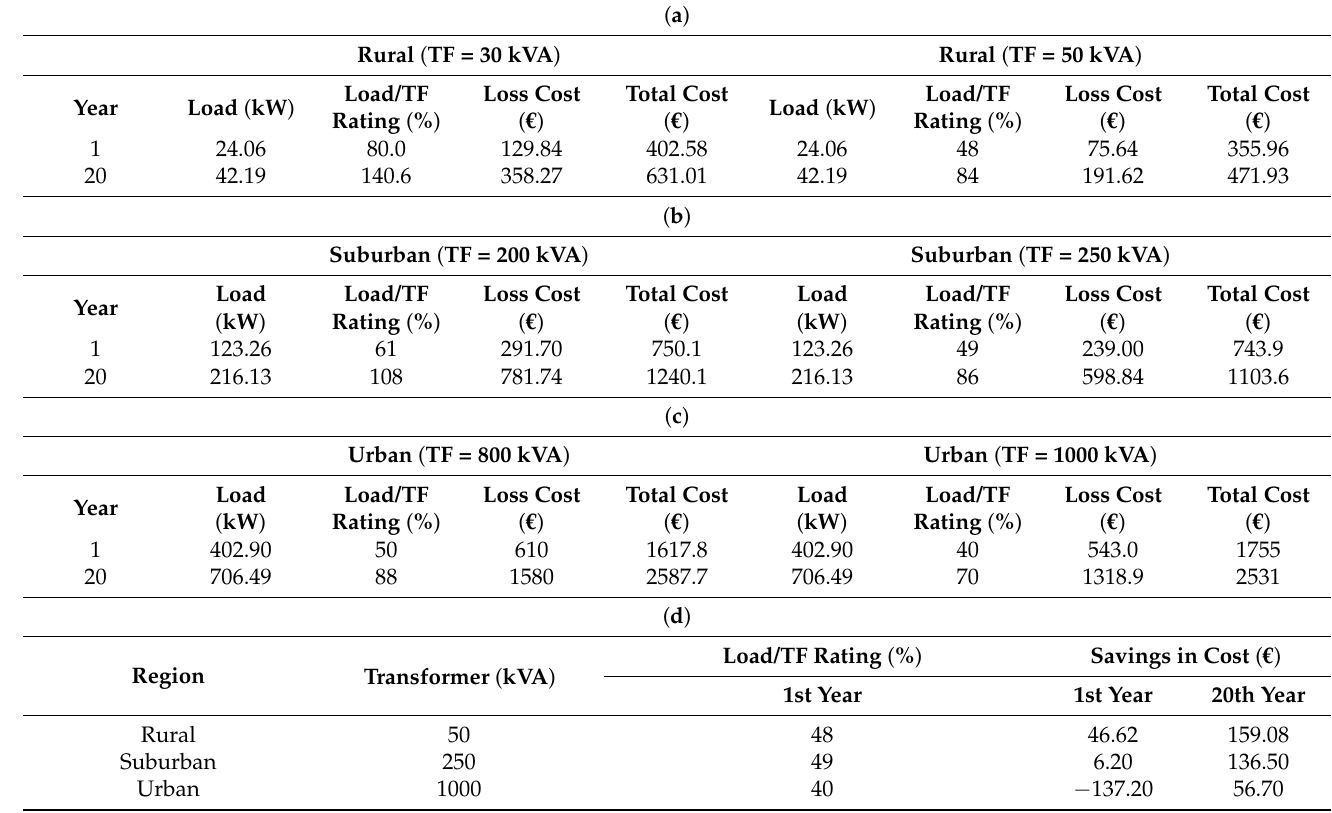
Table 4. Optimal transformer selection and comparison for three Finnish regions. ( a ) Transformer comparison for the rural region. ( b ) Transformer comparison for the suburban region. ( c ) Transformer comparison for the urban region. ( d ) Final transformer selection based on savings in costs by using optimal